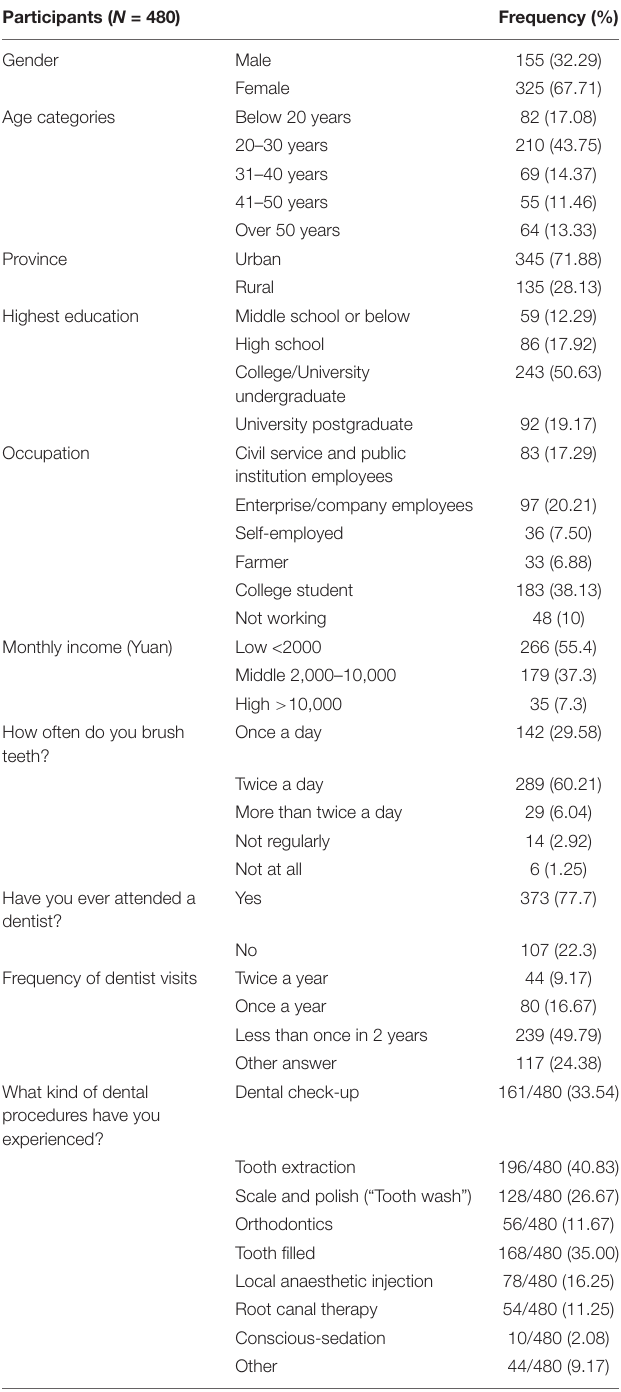
TABLE 1 | Demographics and dental health history and habits of main study participants.